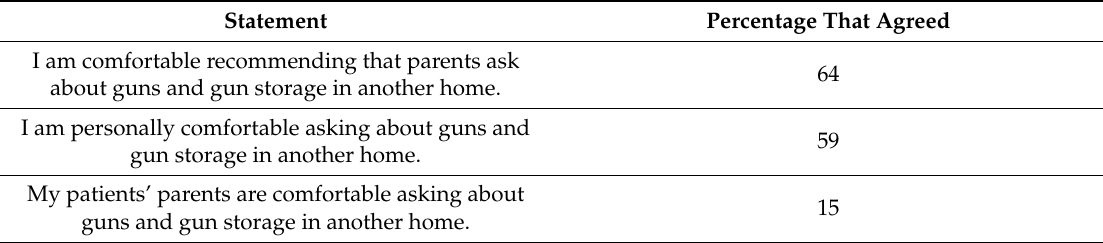
Table 5. Residents’ comfort in regard to asking about guns and gun storage practices in someone’s house before sending a child over to